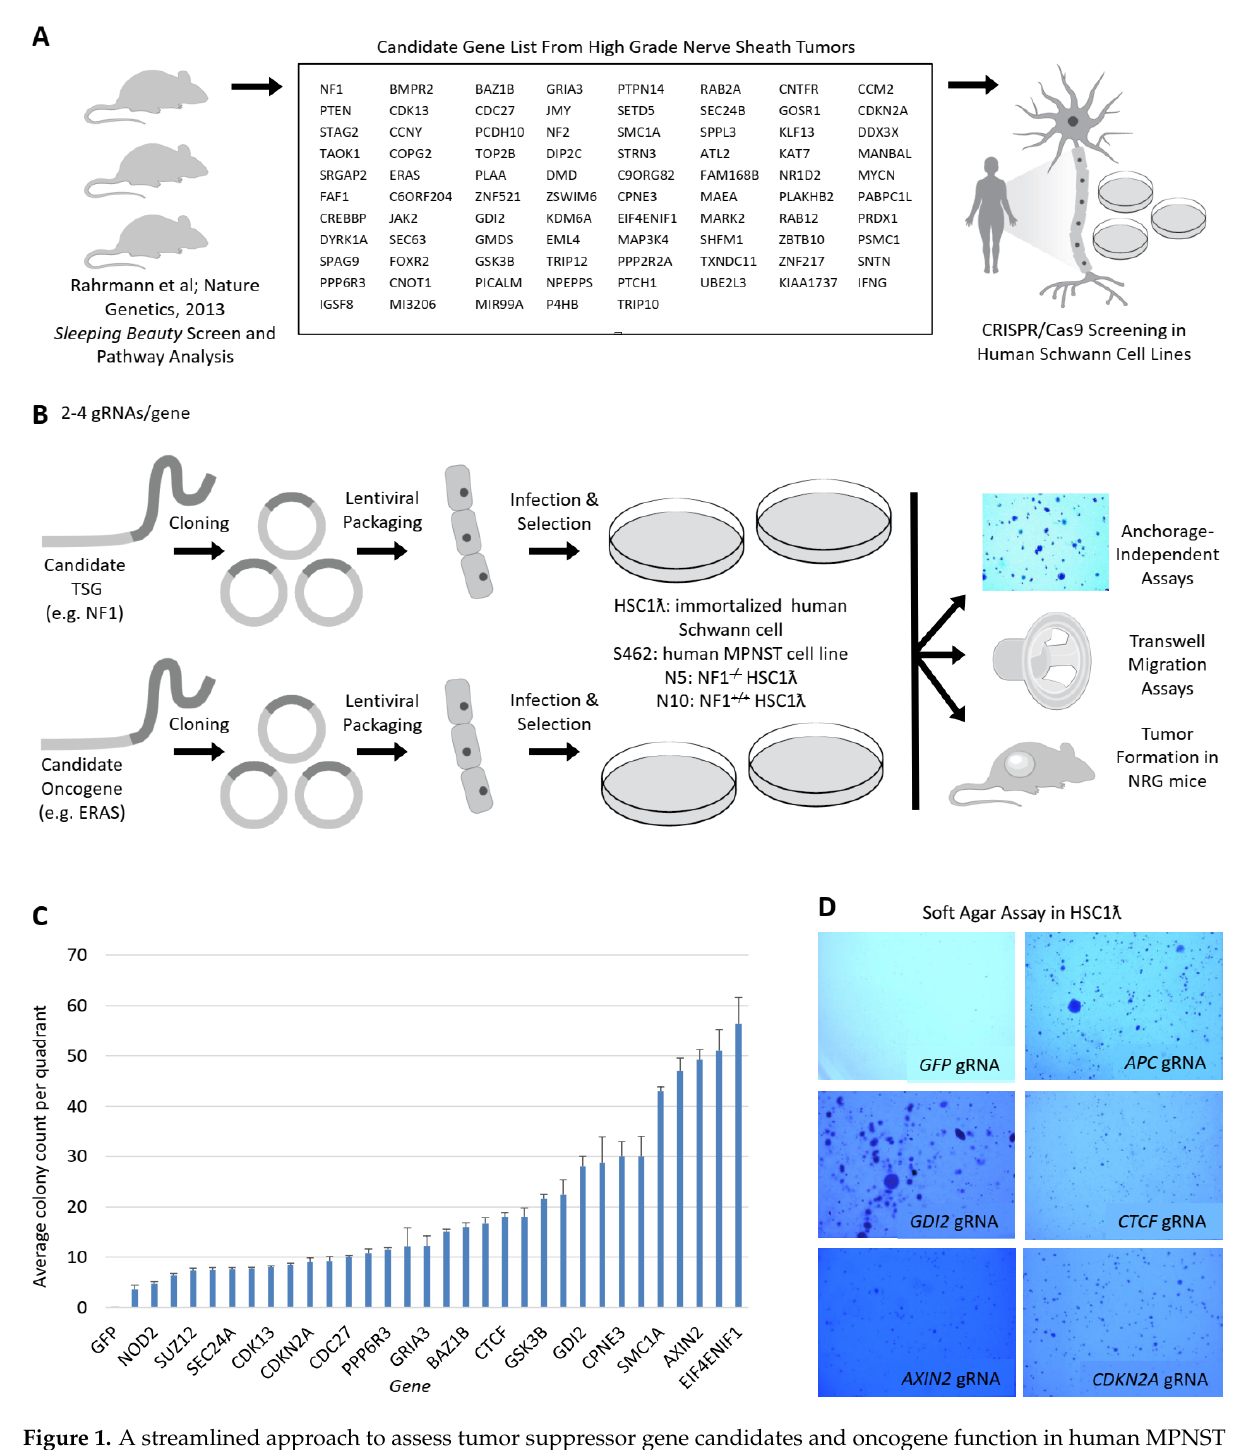
Figure 1. A streamlined approach to assess tumor suppressor gene candidates and oncogene function in human MPNST cell lines reveals novel MPNST pathways. ( A ) Diagram depicting summary of candidate selection from sleeping beauty (SB) screen to CRISPR/Cas9 forward genetic screening. ( B ) Diagram depicting screening method. First, gRNAs were designed to target genes selected in ( A ) and then stable cell lines were created and assessed for transformation upon genetic knockout. ( C , D ) show a summary of scores and anchorage-independent growth for predicted and known tumor suppressor gene candidates (2× magnification).